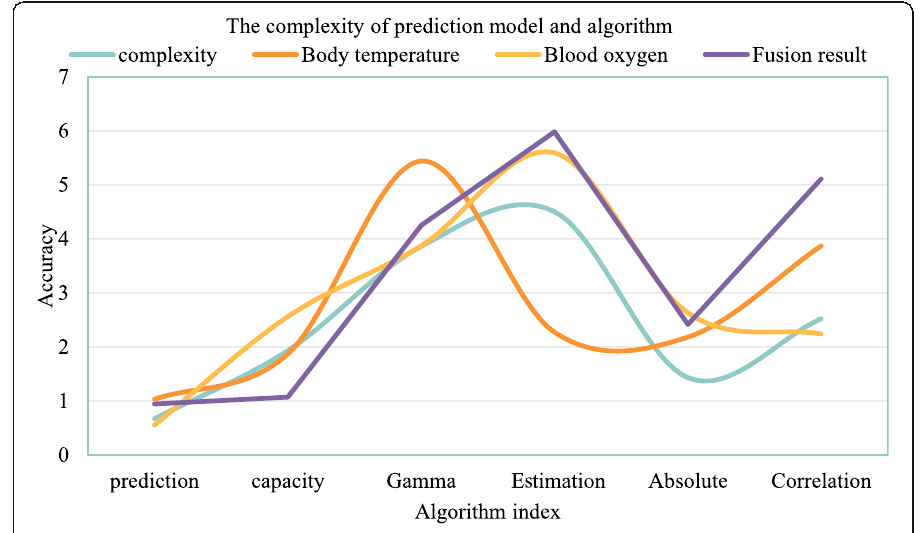
Fig. 10 The complexity of prediction model and